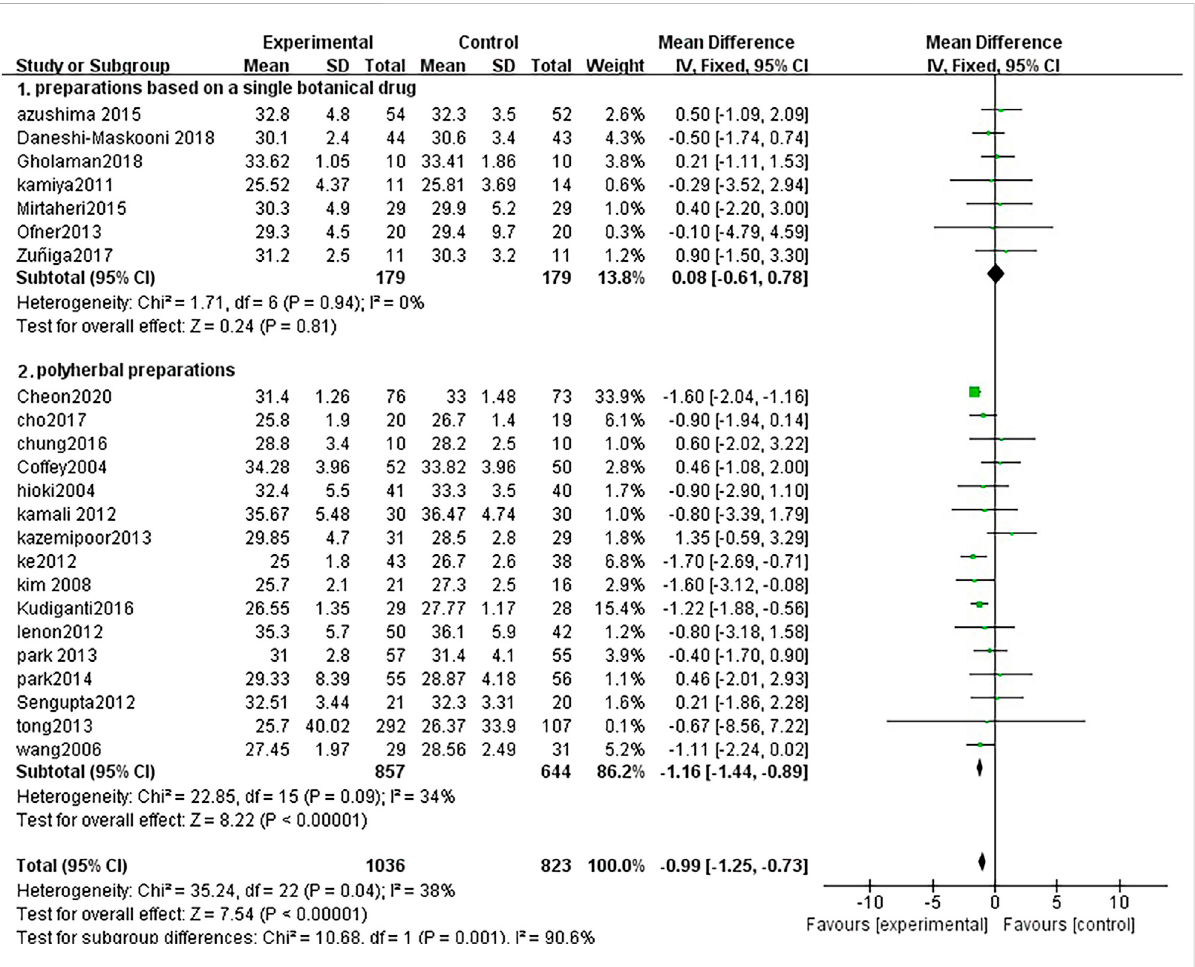
FIGURE 3 Forest plot of BMI. Comparison: TCM treatment (1.preparations based on a single botanical drug 2.polyherbal perparations). vs. placeo or blank control.